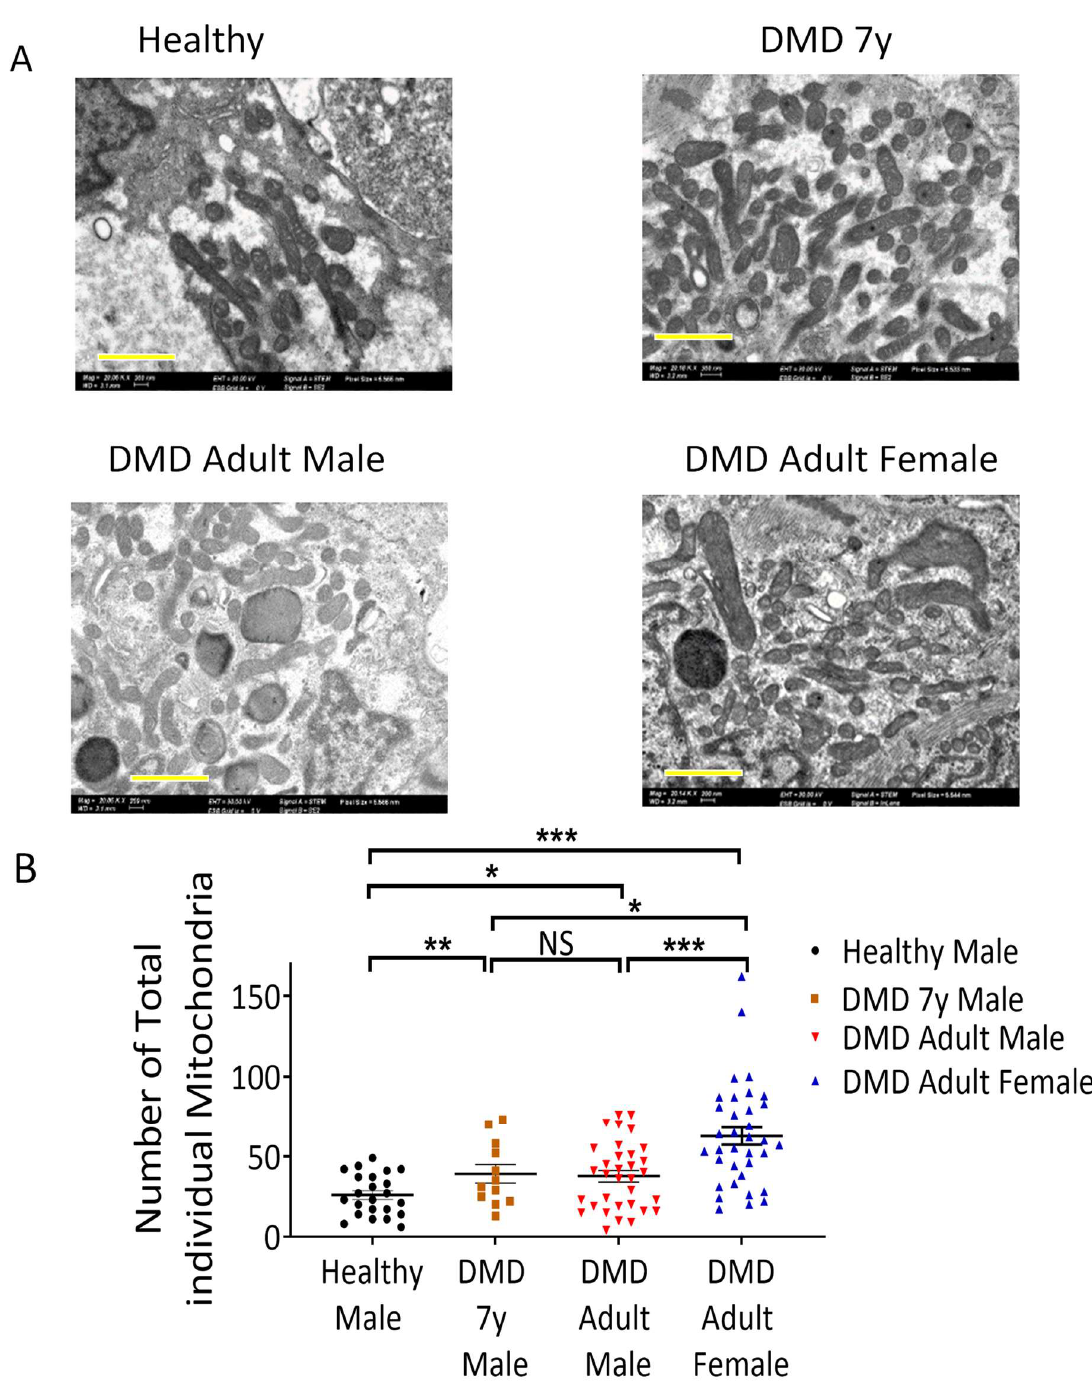
Figure 5. Electron microscopy analyses of mitochondria in iPSC-CMs. ( A ) Mitochondrial morphology and number in healthy control, DMD 7-year-old (7y), DMD adult male and DMD adult female CMs acquired by transmission electron microscopy. Scale bar 500 nm. ( B ) Quantification of the total number of individual mitochondria displayed a significant increase in mitochondria number in DMD 7y, DMD adult male and DMD adult female CMs. Mitochondria counted: healthy, n = 595; DMD 7y, n = 554; DMD adult male, n = 1359; DMD adult female, n = 21,555. Abnormal mitochondria: healthy, n = 11; DMD 7y, n = 11; DMD adult male, n = 296; DMD adult female, n = 556. The Anderson–Darling test of normality was applied for all metabolites to assess whether the data were normally distributed. One-way ANOVA, NS = non-significant, * p < 0.05, ** p < 0.01, *** p < 0.001.